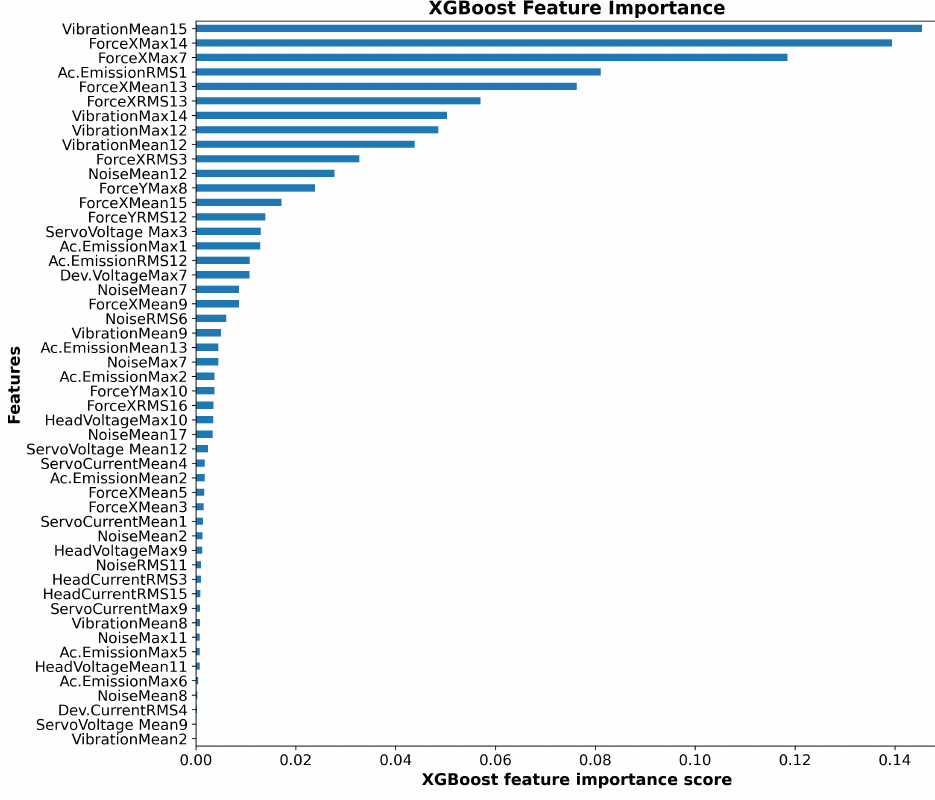
Figure 9. XGBoost feature importance for all (50) important features.